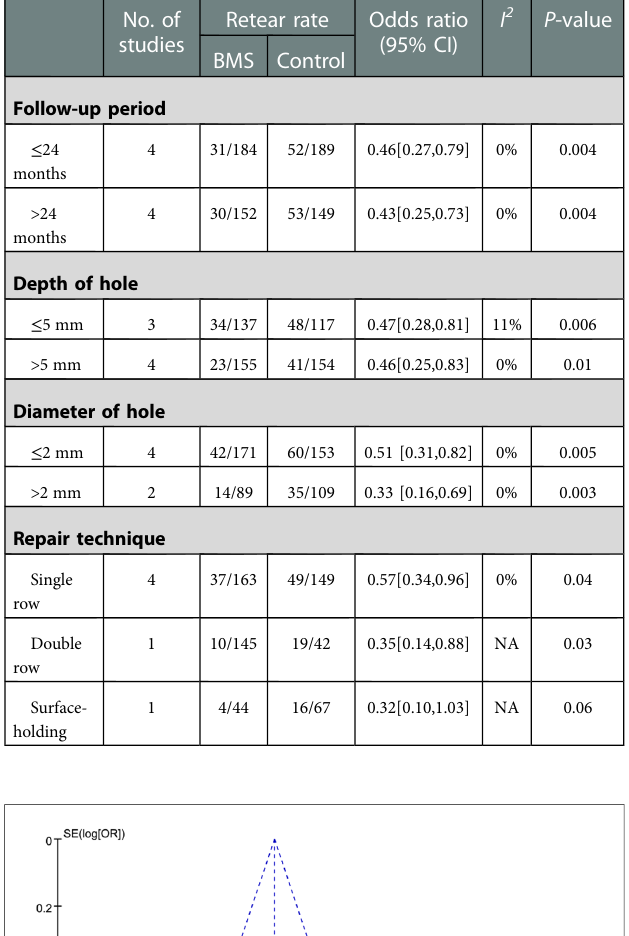
TABLE 5 Subgroup analyses of retear rate.